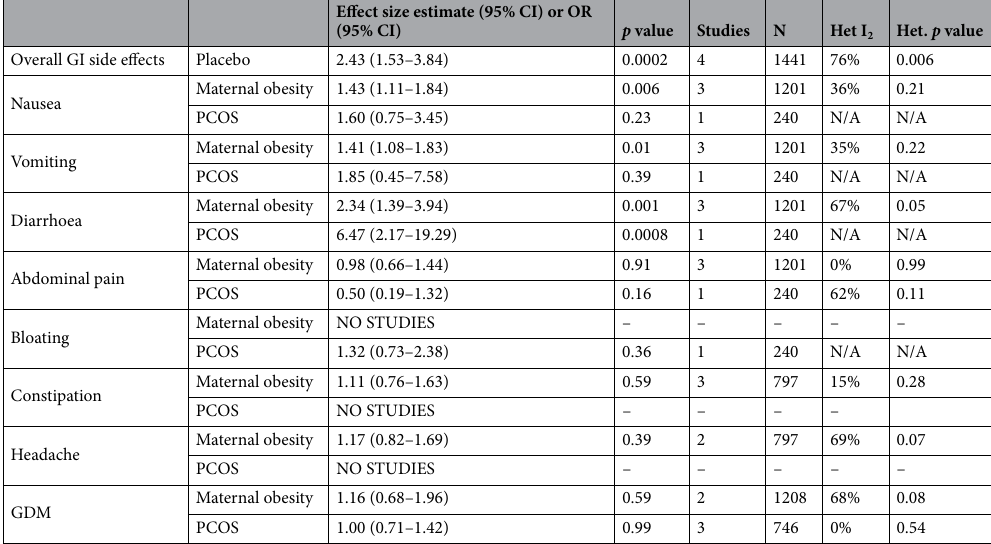
Table 1. Effect of metformin intervention upon common side effects in women with maternal